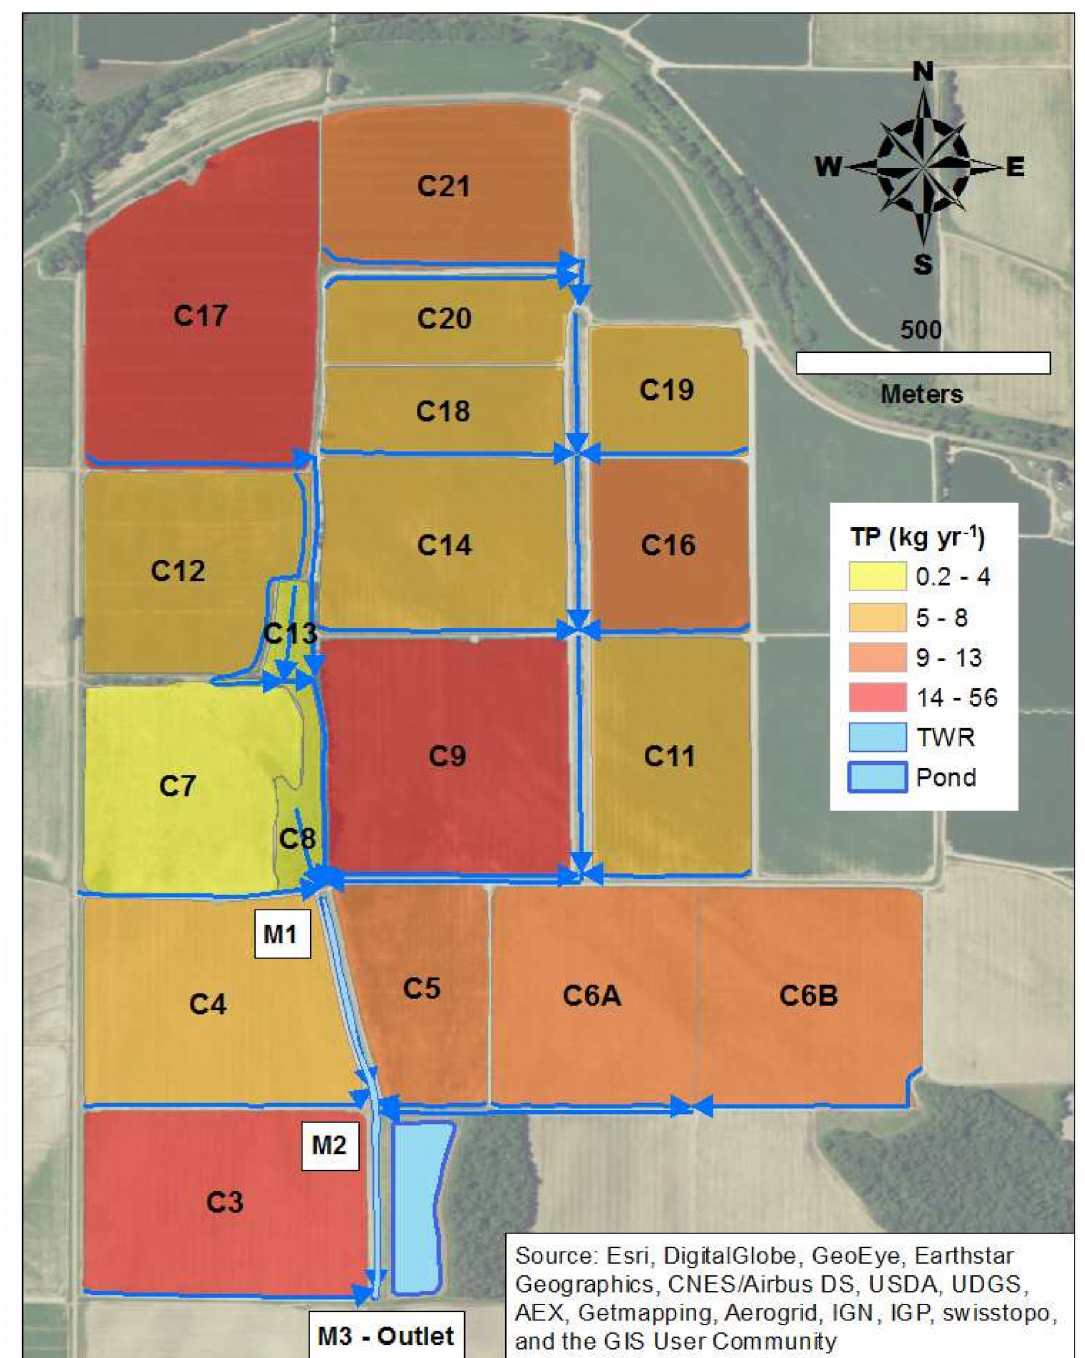
Figure 5. Map of the study area showing the average annual TP load in the simulated watershed. The blue arrows represent the runo ff flow direction towards the outlet. (M1: TWR inlet; M2: TWR mid-canal; M3: TWR outlet; labels within fields indicate the subwatershed identification used by the AnnAGNPS